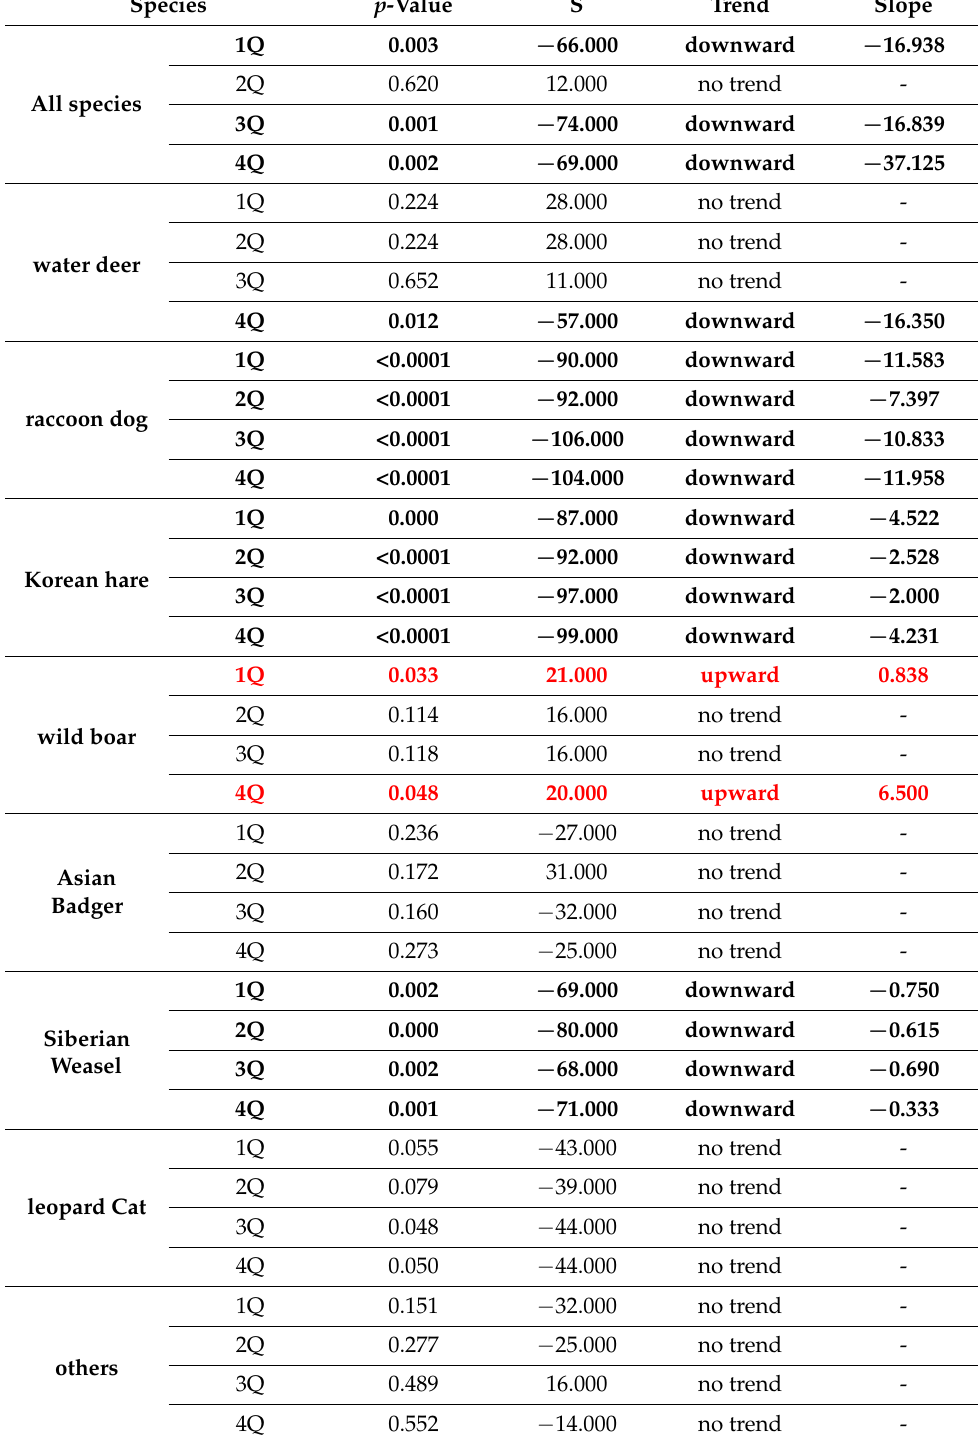
Bold text are significant results, and red text indicates an increasing